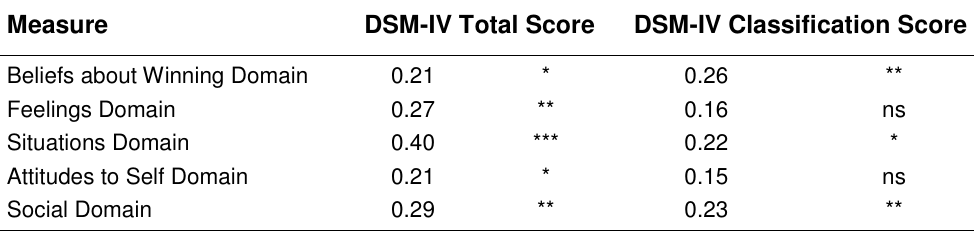
Correlation Coefficients on the Relationships Between the Chinese G-MAP Domain Measures and the DSM-IV